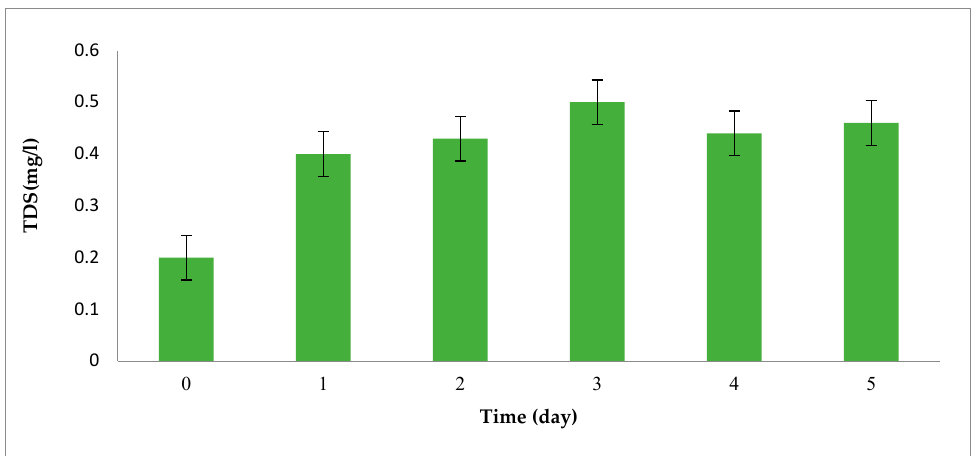
Figure 5. Changes in total dissolved solid (TDS) of food waste hydrolysis by OFAT.